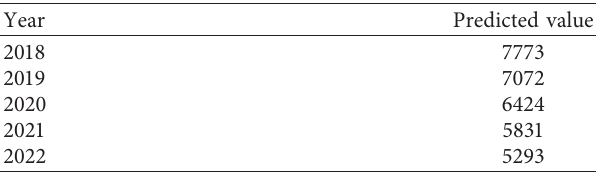
Table 2: The number of enterprise.